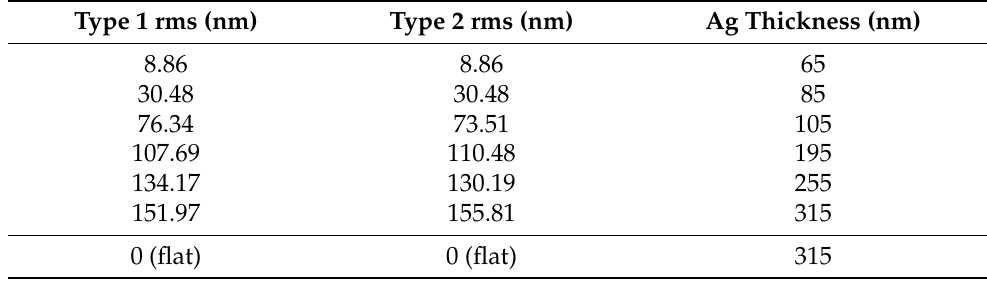
Figure 1. Illustration of the two series of Ag/ZnO setups considered. ( a ) Multilayered structures without rough surfaces for planar reference calculations and ( b ) their corresponding rough top interfaces, where diffraction theory is used in combination with scattering matrix calculations. Table 1. The surface roughness of the different samples used in the calculations and the respective thickness of the Ag layer that best reproduces the experimental